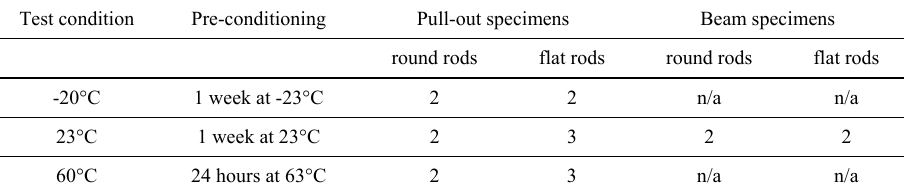
Table 1: Overview of number of test specimens per test